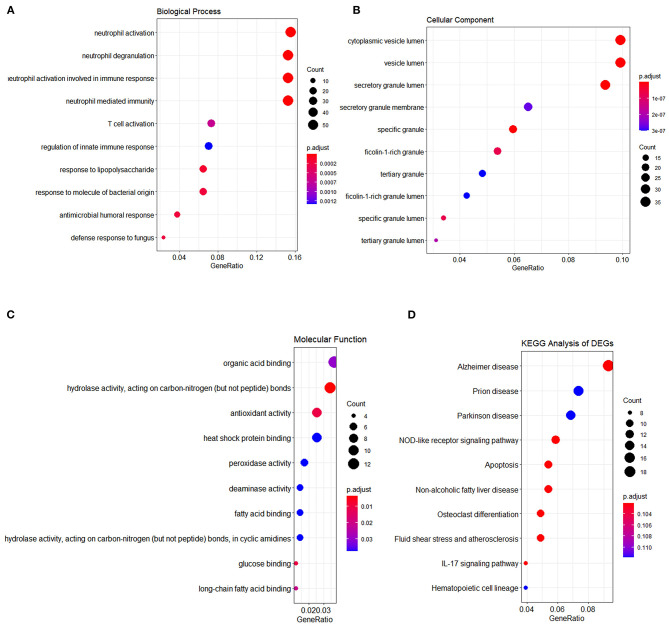
Functional enrichment analysis of DEGs. The results of three major GO enrichment categories are shown in (A) biological process, (B) cellular component, and (C) molecular function, respectively, along with (D) KEGG pathway. The dot size represented the count of differentially expressed genes, and the color depth represented the p-value-based significance.